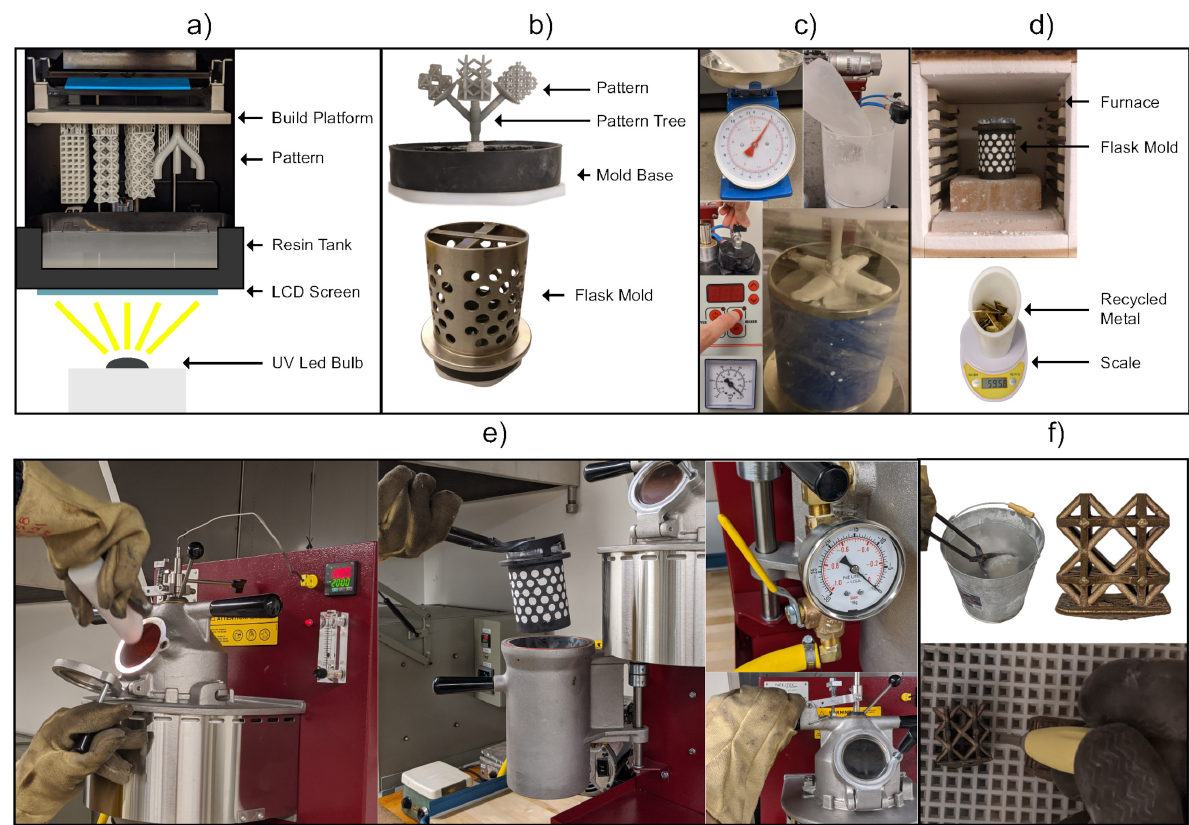
Figure 1. RIC process: ( a ) DLP AM. ( b ) Pattern spruing. ( c ) Plaster mold making. ( d ) Pattern burnout. ( e ) Vacuum casting. ( f )